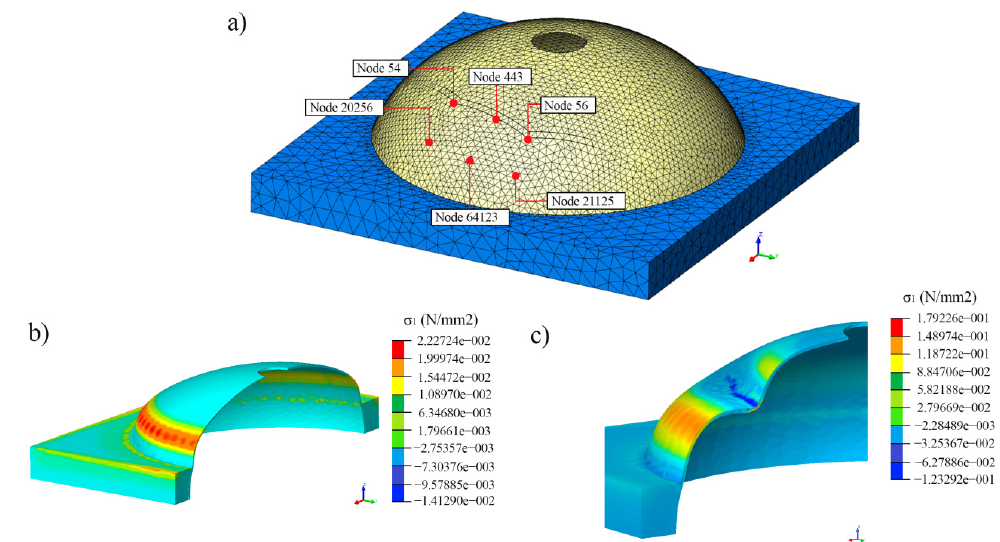
Figure 8. ( a ) Isometric view of the mesh and the control points (nodes) used for the numerical simulations; ( b ) First principal stress distribution, expressed in N/mm 2 for the self-weight case;